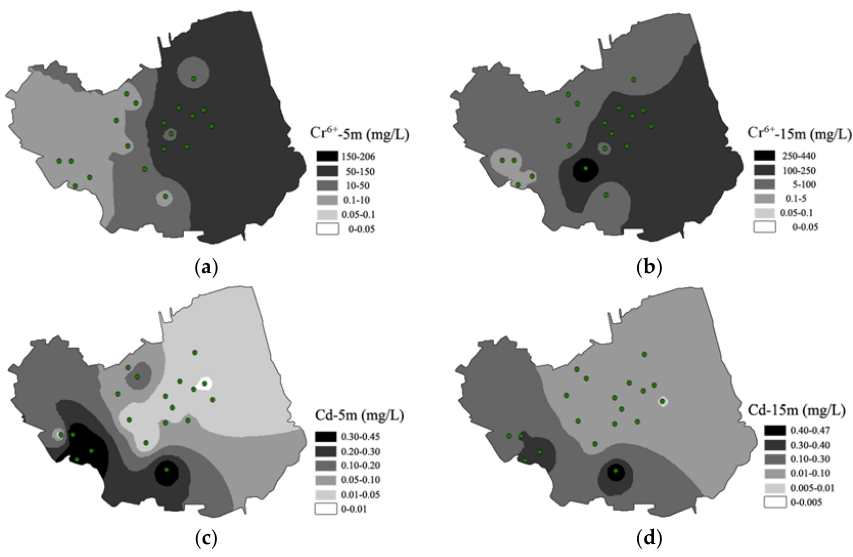
Figure 3. Spatial distribution of Cr 6+ ( a , b ) and Cd ( c , d ) in groundwater at depths of 5 m and 15 m.